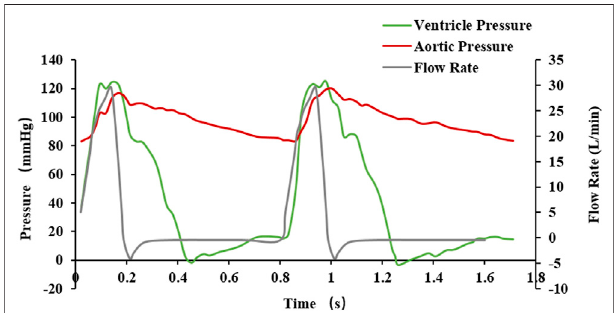
FIGURE 7 | Fluctuating load boundary curve.